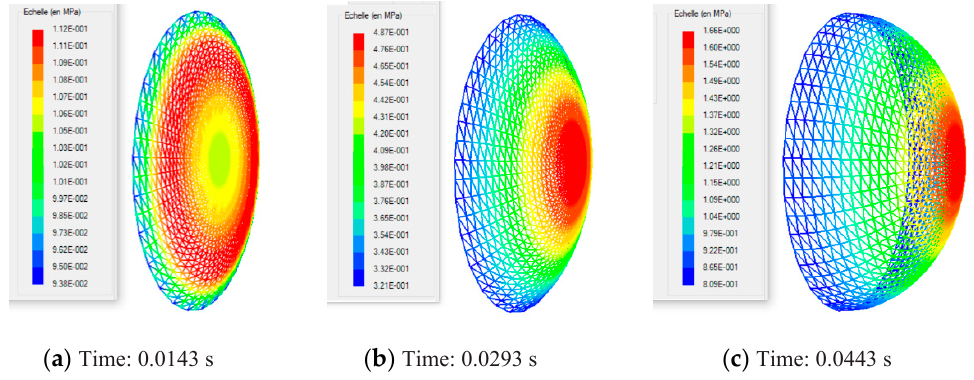
Figure 13. MD model: von Mises stresses induced in PMSQ–HDPE at times of 0.0143 ( a ), 0.0293 ( b ), and 0.0443 s ( c ).